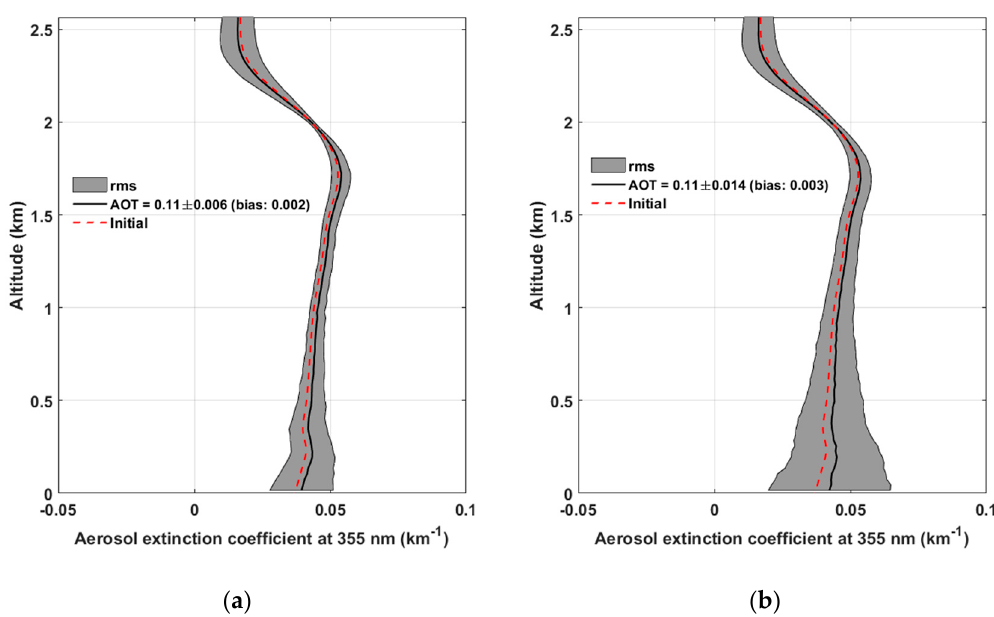
Figure 11. Vertical profiles of the aerosol extinction coefficient (AEC) retrieved using the Monte Carlo approach for: ( a ) the effect of uncertainty over the reference zone and ( b ) the simultaneously effects of uncertainties over the reference and constraint zones. The “true” input profile is given by the red dotted line; the mean AEC retrieval is given by the black continuous line. The standard deviation (rms) is highlighted in gray.